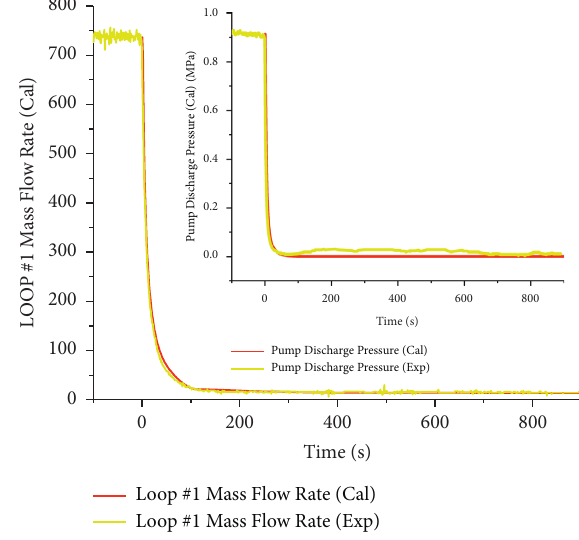
Figure 13: Mass flow rate in loop